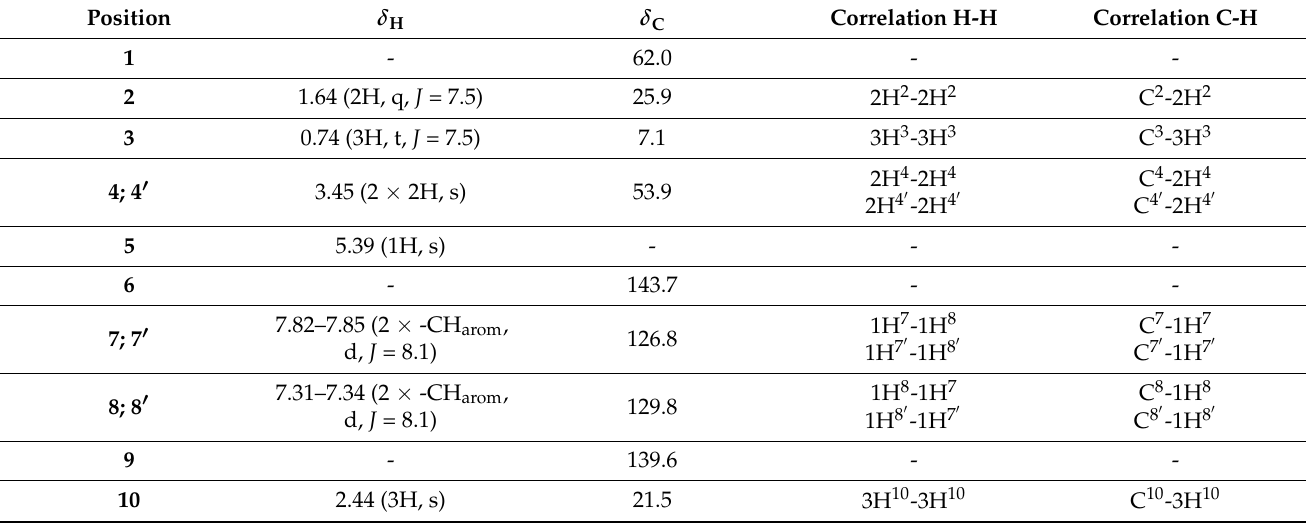
Table 2. 1 H (300 MHz) and 13 C (75 MHz) NMR spectral data for compound ( 3 ) in CDCl 3 , including results obtained by homonuclear 2D-shift-correlated and heteronuclear 2D-shift-correlated HMBC. Chemical shifts ( δ in ppm) and coupling constants ( J in